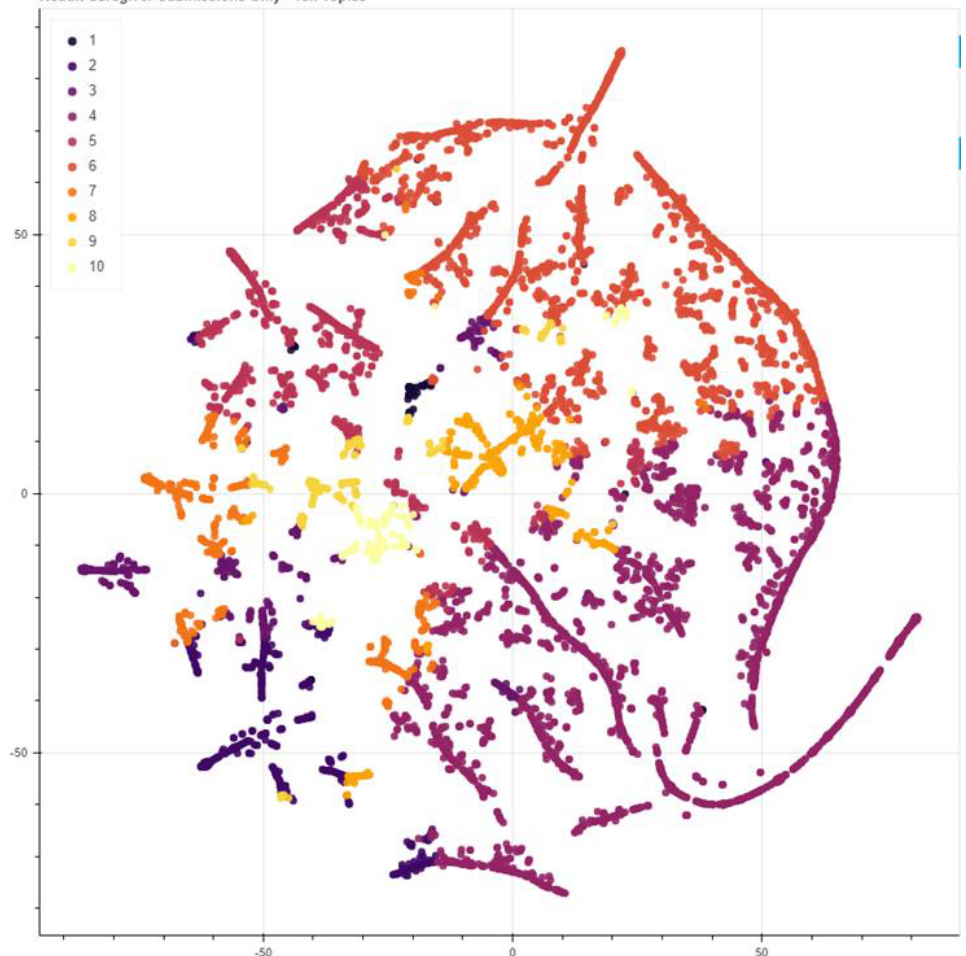
Figure A1. t — SNE plot of topic clusters for interactive viewing of posts. Each dot represents a Reddit submission post. Clustering or shapes represents cohesiveness in the body of the text. Colors represent topic themes (1 – 10). Hovering over a dot provides the associated text in the Reddit submission post allowing for quick ingestion of complex themes.